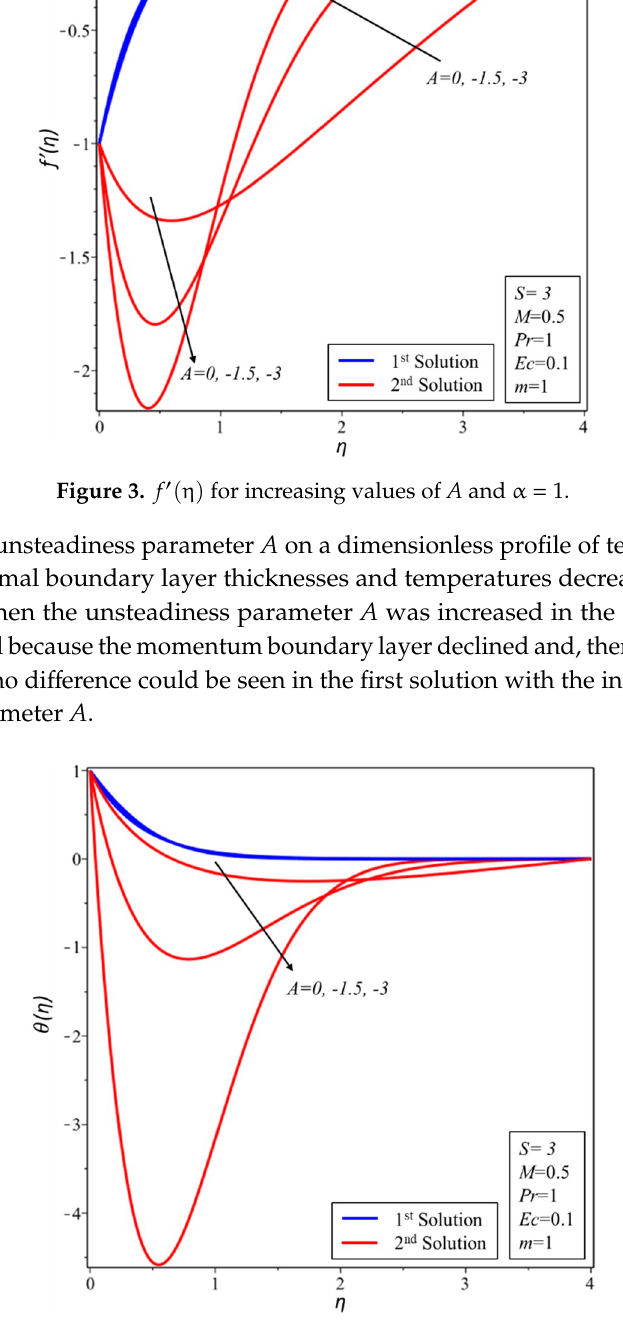
Figure 4. θ(η) for increasing values of A and α = 1.